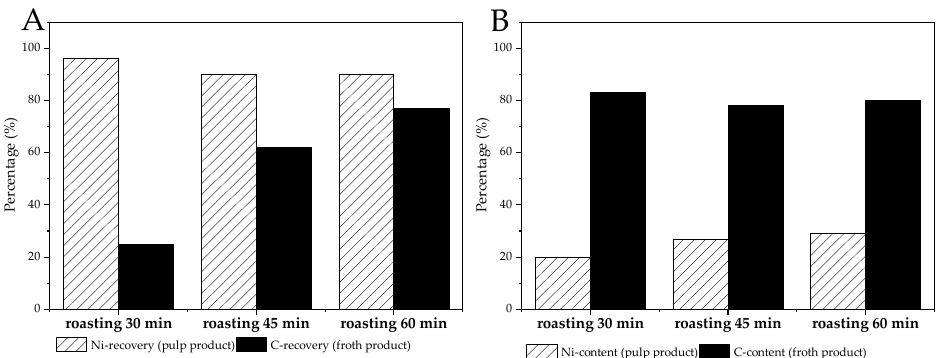
Figure 11. ( A ) Recoveries and ( B ) contents of flotation products obtained from the BM after different roasting times.